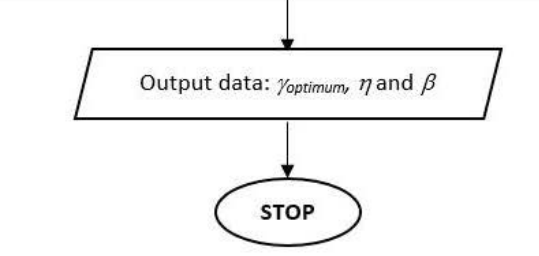
Figure 3. Flowchart for the proposed methodology.